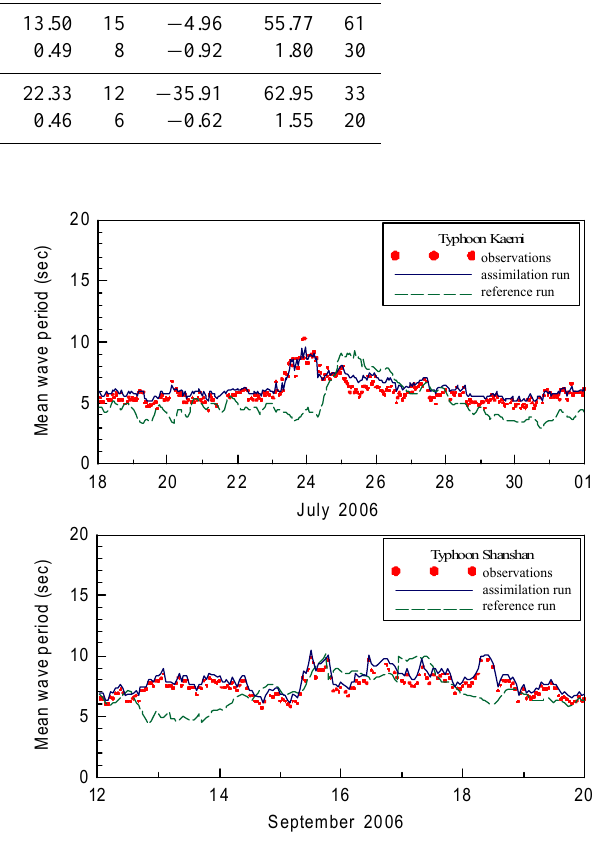
Fig. 5. SWH time series at the Hualien buoy (a) during Typhoon Kaemi and (b) during Typhoon Shanshan. Fig. 6. MWP time series at the Hualien buoy (a) during Typhoon Kaemi and (b) during Typhoon Shanshan.